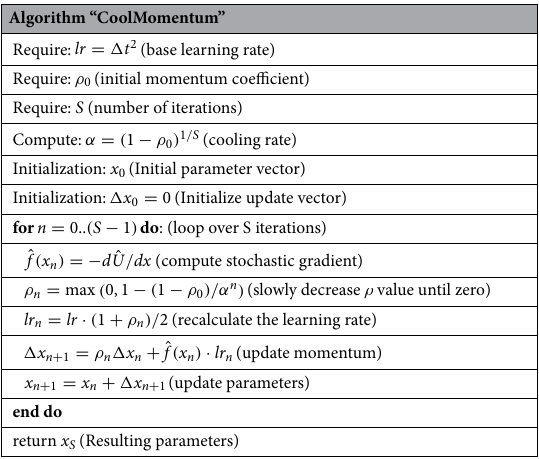
Table 1. Pseudocode